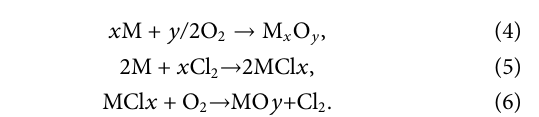
Frontiers in Materials |